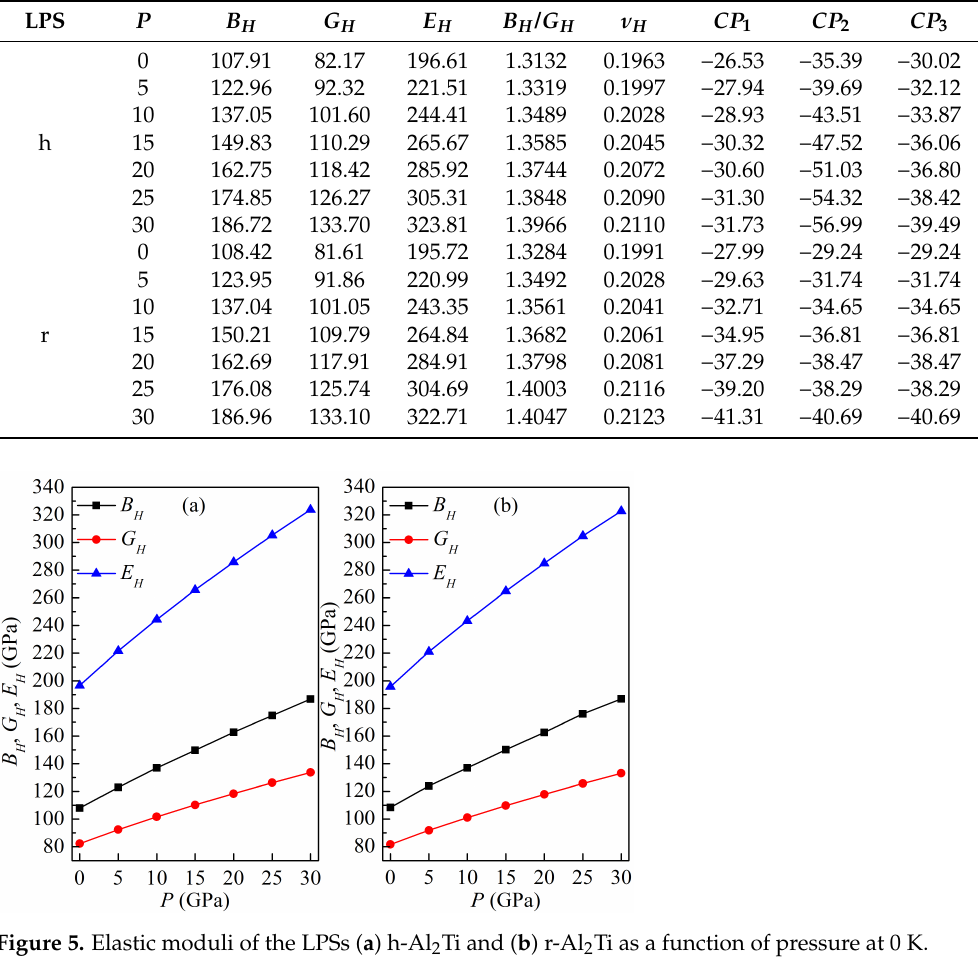
Table 4. Calculated elastic moduli and Cauchy pressures (in GPa) for the LPSs h- and r-Al 2 Ti under pressure up to 30 GPa at 0 K.